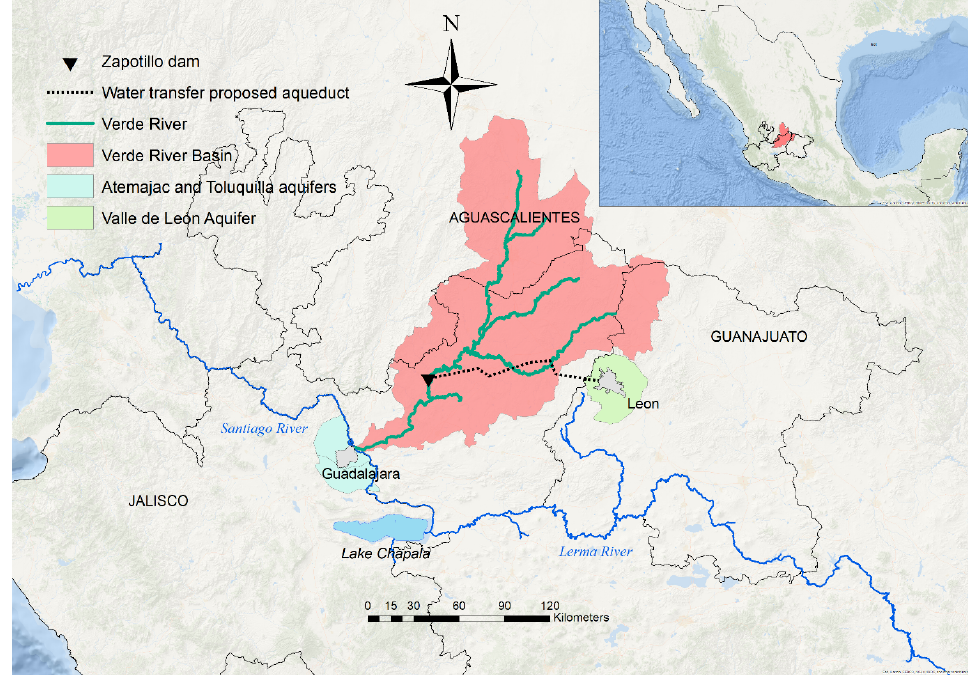
Figure 1. Map of the Verde River basin and main cities (source of GIS layers: © Conagua , 2018, and © Esri , 2019, Garmin, GEBCO, NOAA NGDC, and other contributors).